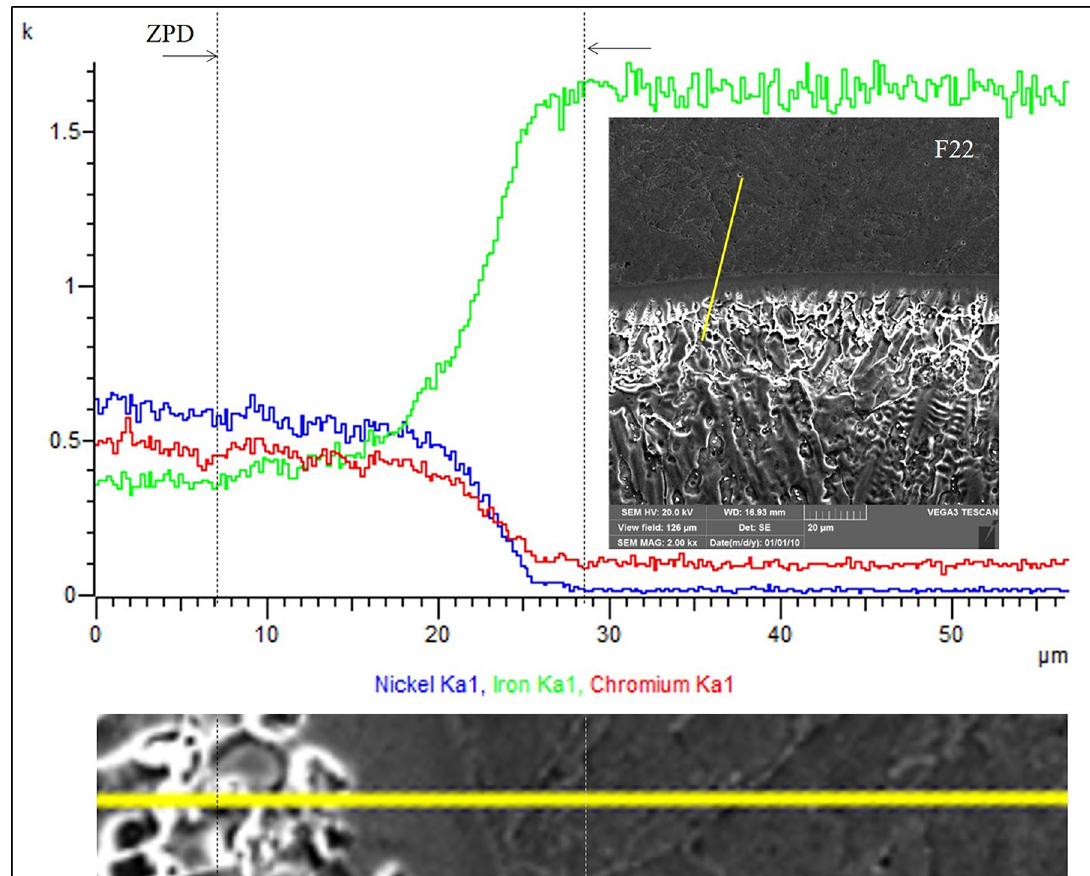
Figure 6. EDS, from the NCS, the butter weld interface after